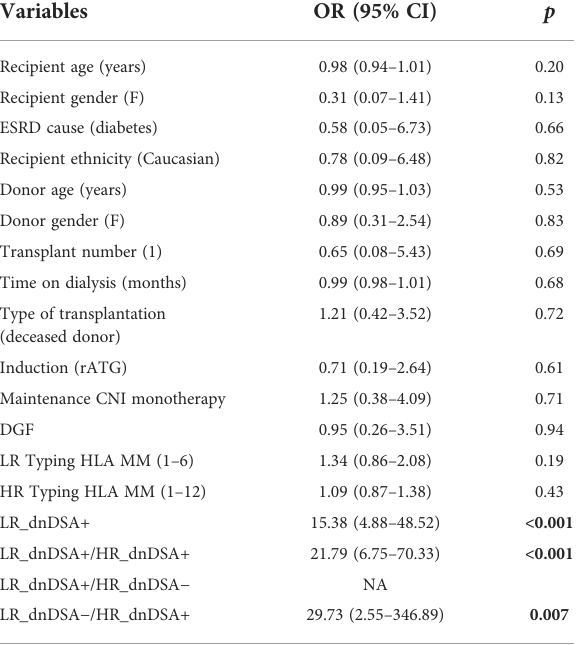
TABLE 4 Univariate logistic regression analysis of main clinical, demographic, and immunological variables associated with ABMR. Variables